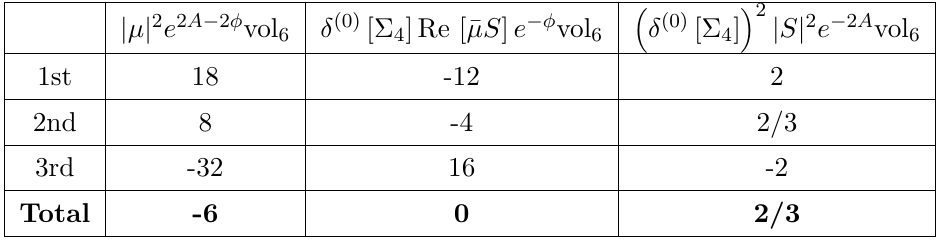
Table 1 . The different contributions to the bulk on-shell action of the terms in the first three lines of